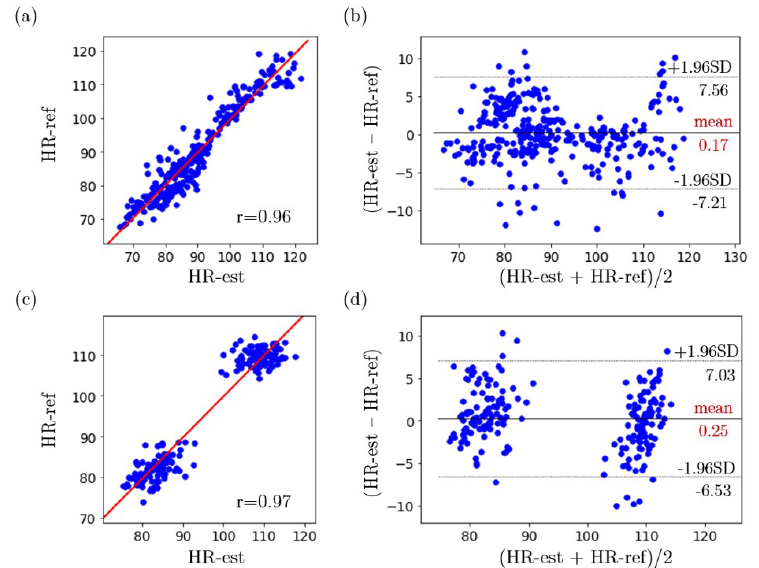
Figure 15. ( a ) Correlation plot of the estimated HR and reference HR for subjects who have a pale skin tone, ( b ) Bland–Altman plot of the estimated HR and reference HR for subjects who have a pale skin tone, ( c ) Correlation plot of the estimated HR and reference HR for subjects who have medium or dark skin tones, ( d ) Bland–Altman plot of the estimated HR and reference HR for subjects who have medium or dark skin tones.